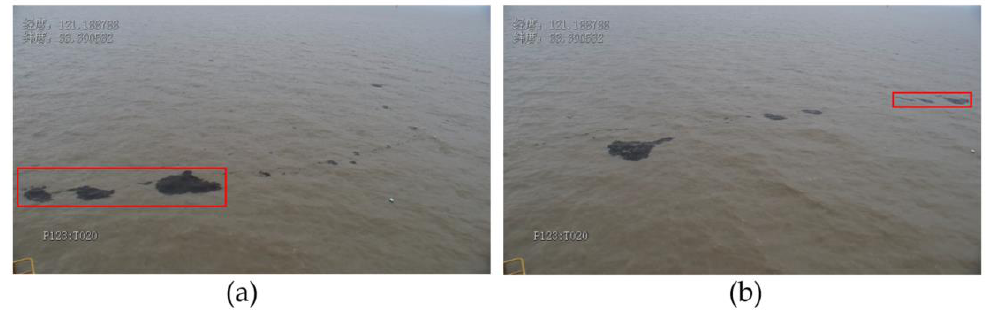
Figure 5. The scale variety for the floating-algae detection task. ( a ) is the floating algae closer to the camera. ( b ) is the floating algae far from the camera.